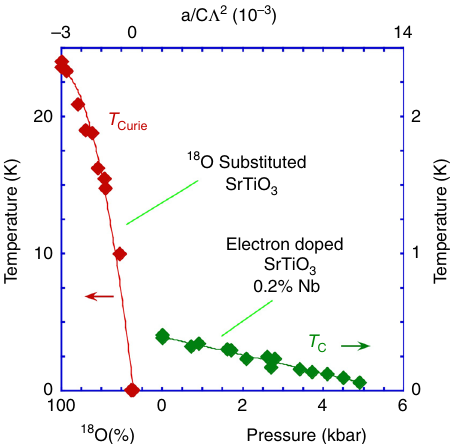
Fig. 4 The calculated superconductivity phase diagram for Nb-doped Fig. 5 The overall observed phase diagram for SrTiO 3 near to the SrTiO 3 . The normalized superconducting transition temperature, T c ferroelectric quantum critical point. The top horizontal axis is the quantum calculated via the model given by Eqs. (1) – (5) and the material parameters tuning parameter referred to in Fig. 1 that may be calculated from the relevant to SrTiO 3 (see “ Methods ” section), is shown (i) vs. pressure, p , for applied pressure or isotopic substitution (bottom horizontal axis). The values of n around the superconducting dome (Fig. 2a), log( n /cm − 3 ) = 19, parameters a , c and Λ de fi ning the quantum tuning parameter g = a /( c Λ 2 ) 20, 20.5, 21, from the upper to the lower curves, respectively, in the main are, respectively, the coef fi cients of the quadratic and gradient-squared fi gure, and (ii) vs. n at p = 0 for different values of the carrier mass, m / m e terms and the cut-off wavevector in the ϕ 4 fi eld theory 3 . g may be varied by = 2, 3 and 4, in the inset. T = 0 cmax corresponds to the maximum of T c at p pressure, chemical substitution, strain, isotope substitution, or charge- in the main fi gure and the dome maximum in the inset. The ratio T c / T cmax carrier density to tune between ferroelectric, paraelectric, and in contrast to T c itself depends only weakly on the cut-off frequency used to superconducting phases. From left to right, the Curie temperature collapses evaluate Eqs. (1) – (5) (see “ Methods ” section and Fig. S3). The close with increasing g and gives way to superconductivity in the presence of correspondence with the observed phase diagram (Fig. 2a) suggests that carrier doping. Note that at the carrier density given in the fi gure, the soft the pairing mechanism modelled by Eqs. (1) – (3) plays a key role in transverse-optical frequency and hence proximity to the QCP is not far superconductivity in SrTiO 3 . T cmax is found to be in the mK range based on from that in the undoped state S34 (see “ Methods ” section). The phase a realistic choice of parameters as outlined in the “ Methods ” section for diagram is consistent with the model de fi ned by Eqs. (1) – (5) for the SrTiO 3 and as originating purely from the model described by Eqs. (1) – (3) superconducting transition, and with the model in ref. 3 for the Curie in the main text and without a direct coupling to the transverse-optic temperature, both calculated in terms of independently measured ferroelectric critical temperature-independent model parameters for SrTiO 3 .